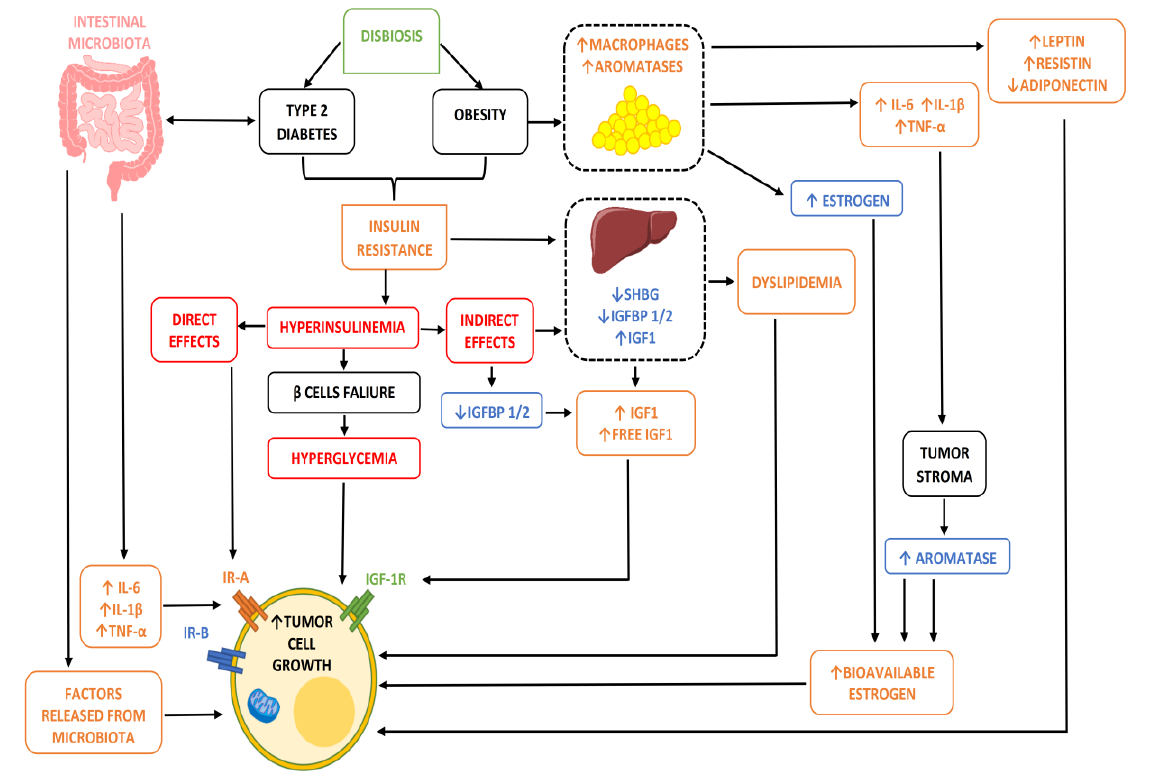
Figure 1. Correlation between more frequent metabolic disorders and tumor growth. The microbiota favoring or disfavoring the onset of metabolic disorders ends up impacting the onset and progression of neoplastic disease.